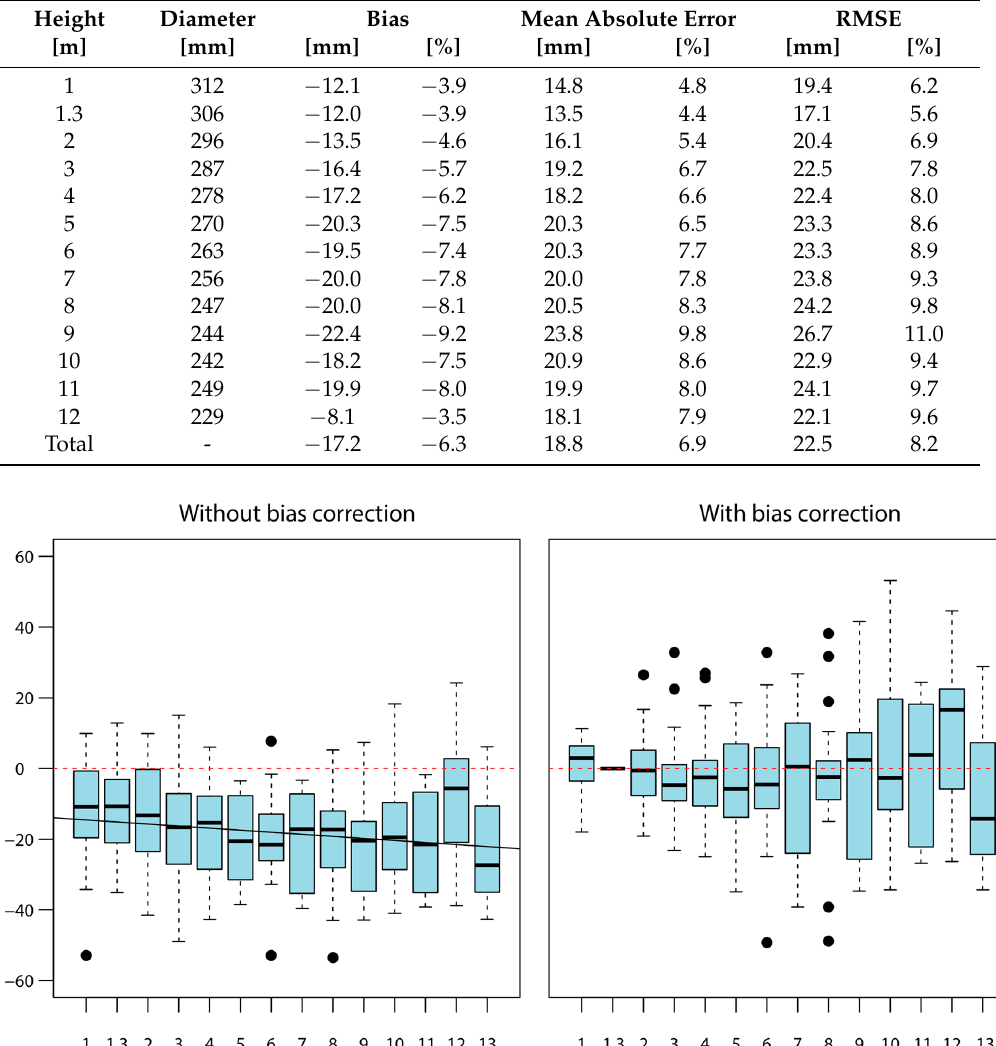
Table 3. Variation along the stem of diameter measurement error from PPC. Diameter is the diameter measured in the field. RMSE, root mean square error.